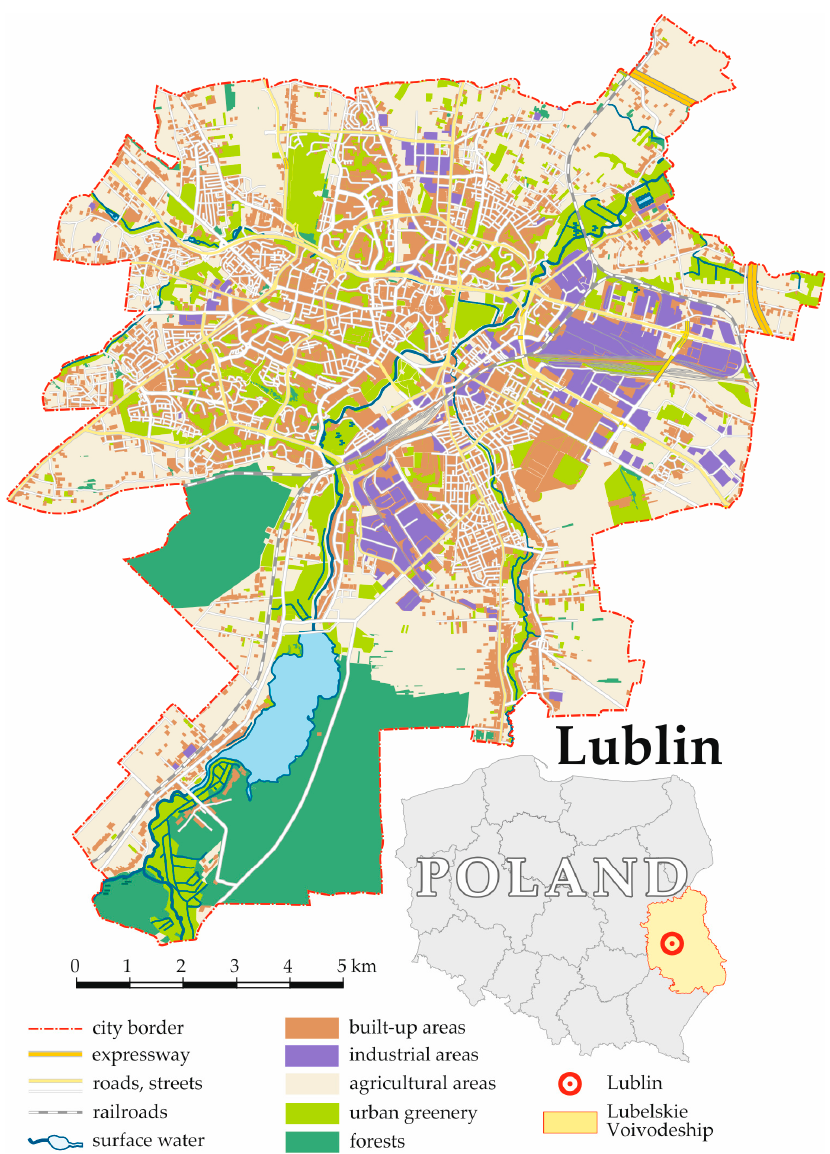
Figure 2. Location and the functional–spatial structure of Lublin.